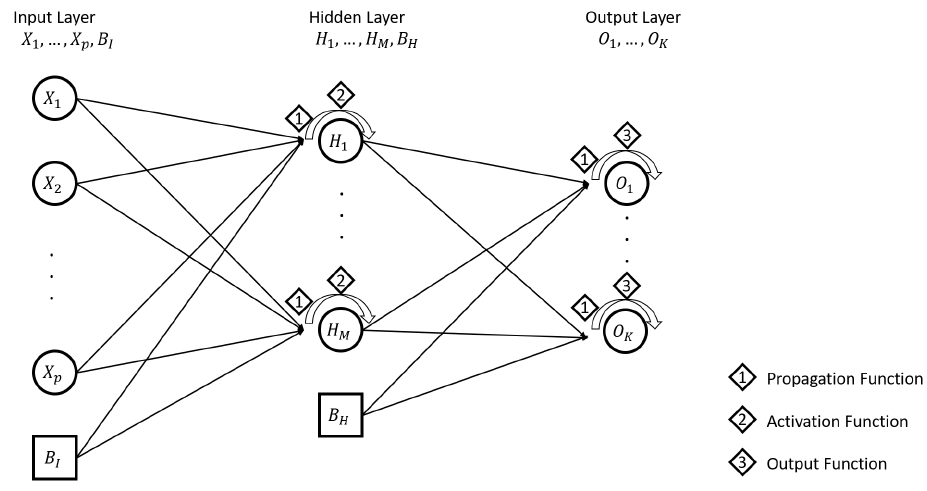
Figure 2. Structure of neural networks with one hidden